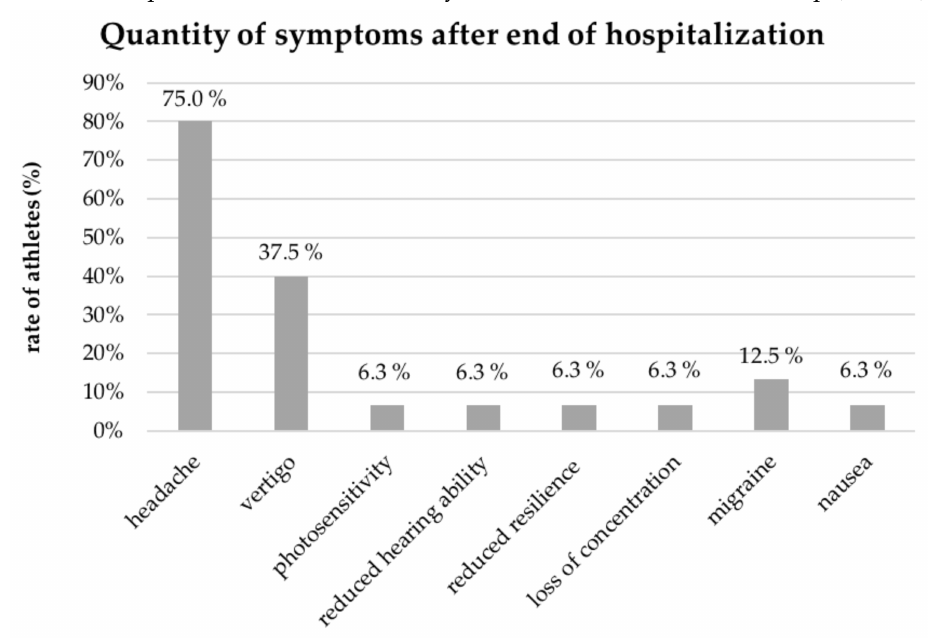
Figure 1. Symptoms after discharge from